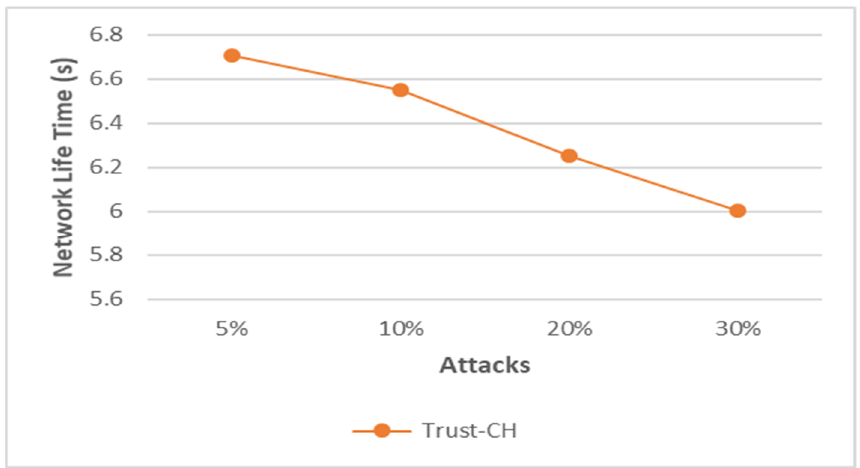
Figure 10. Analysis of the influence of the number of attacks on the Trust-CH network lifetime.